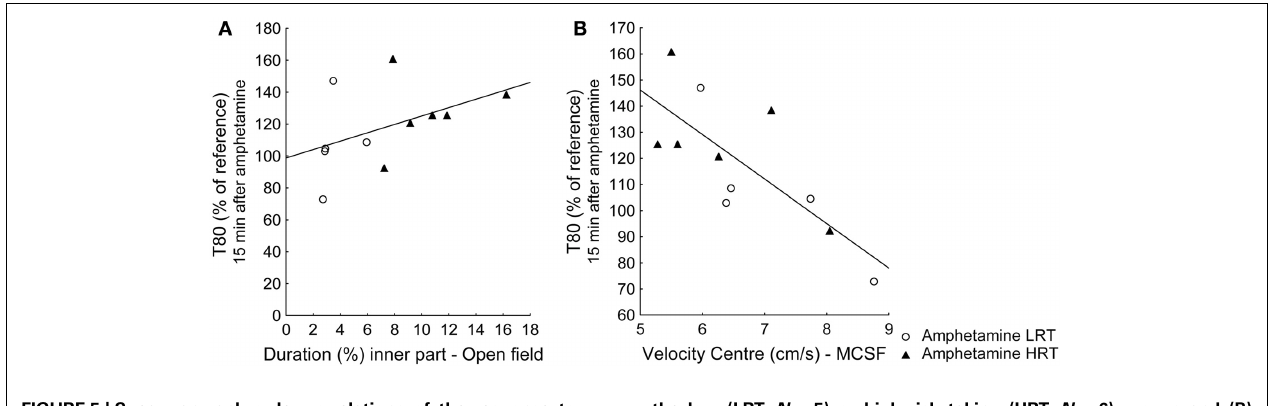
the low (LRT, N = 5) or high risk taking (HRT, N = 6) groups and (B) the velocity in the center of the multivariate concentric square field™ (MCSF)